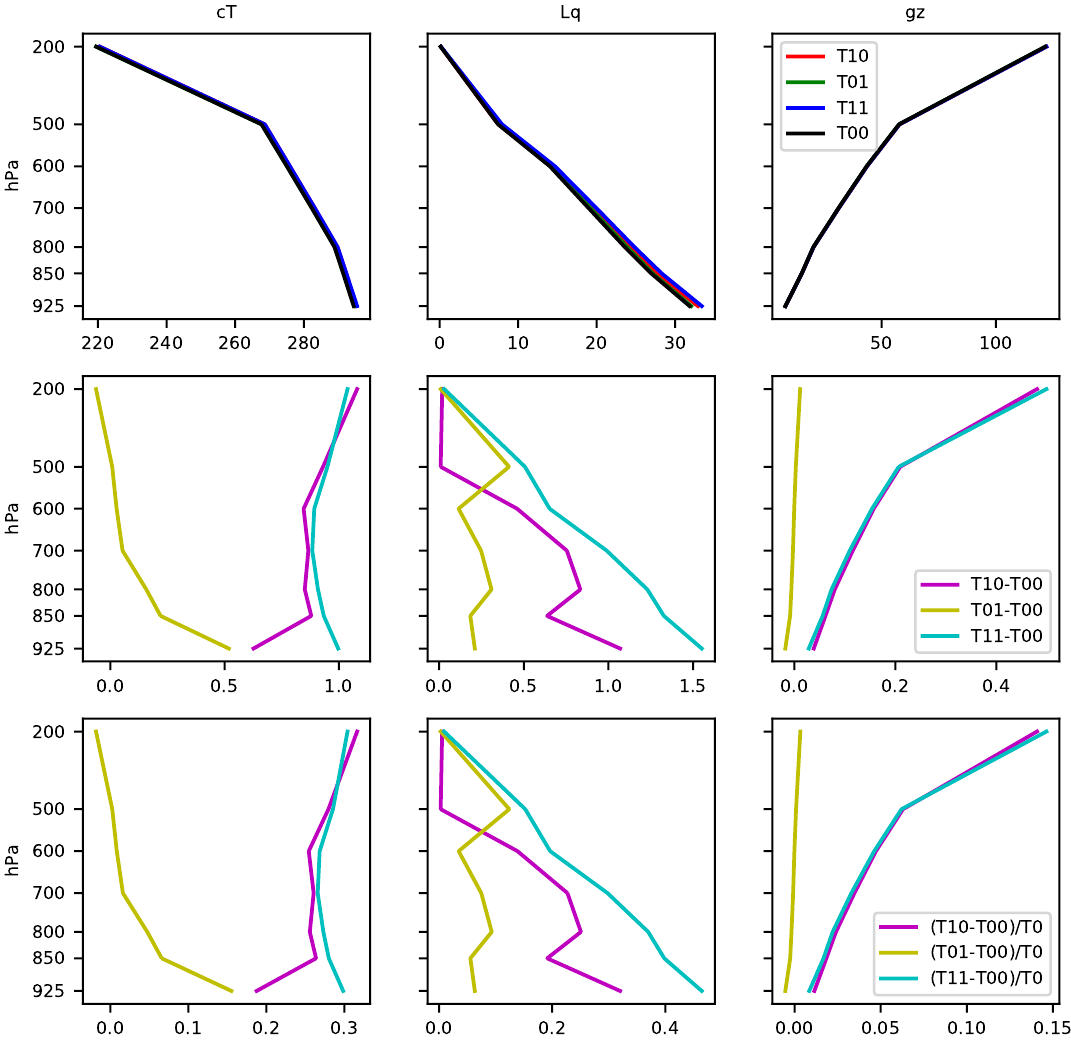
Figure A4. Guinea regional mean JAS MSE terms for the control run and sensitivity experiment (J g − 1 , top ), anomalies (J g − 1 , center ) and changes relative to total MSE control value (%, bottom ). All values are study period